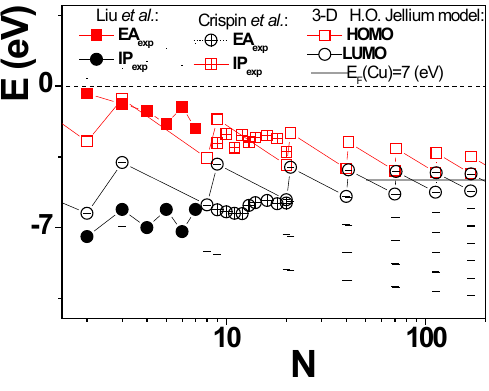
Figure 3. Shell structure obtained for Cu N AQCLs under the approach of the 3D harmonic oscillator potential. The HOMO and LUMO show enhanced stability for certain N, which corresponds to magic numbers (shell closures). Experimental data of ionization potential (IP) and electron affinity (EA)EA are from Crispin et al . [17] and Liu et al .